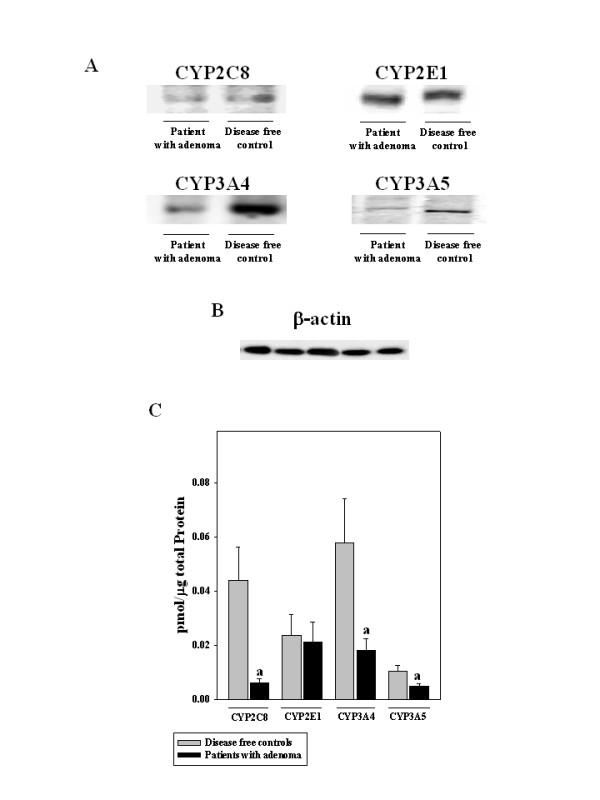
Diminished protein levels of CYP2C8, CYP3A4, and CYP3A5 in normal colon mucosa of patients with colonic adenoma. (A) Representative Western blots of CYP2C8, CYP2E1, CYP3A4, and CYP3A5 in normal colon mucosa from patients with colonic adenomas and disease-free controls. (B) Representative Western blot of β-actin protein in normal mucosa of patients with colonic adenoma and disease-free controls. (C) Quantitative analysis of blots. CYP2E1, CYP3A4, and CYP3A5 protein levels were determined in 25 patients with adenoma und 27 disease-free controls. CYP2C8 protein levels were determined in 19 cases and 12 disease-free controls. Data are means ± SEM, ap < 0.05 compared to disease-free controls.